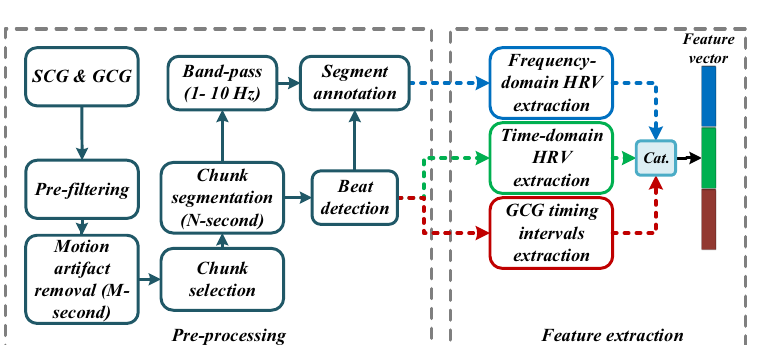
Figure 3. Left panel: pre-processing, right panel: feature extraction flow graphs. In the pre-processing step, motion artifacts and baseline wandering are removed from signals, which is followed by signal segmentation, peak detection, and annotation. Feature extraction is carried out for time and frequency HRV parameters as well as the GCG morphological features. Features are eventually concatenated to create a feature